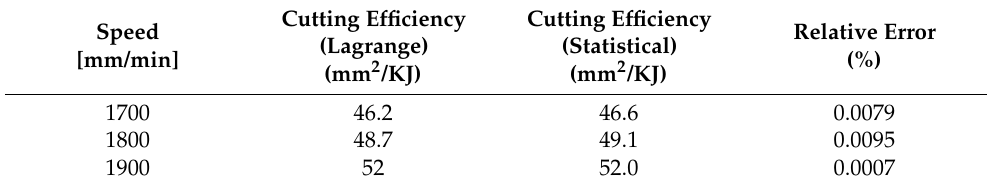
Table 9. Lagrange cutting efficiency and statistical calculation.